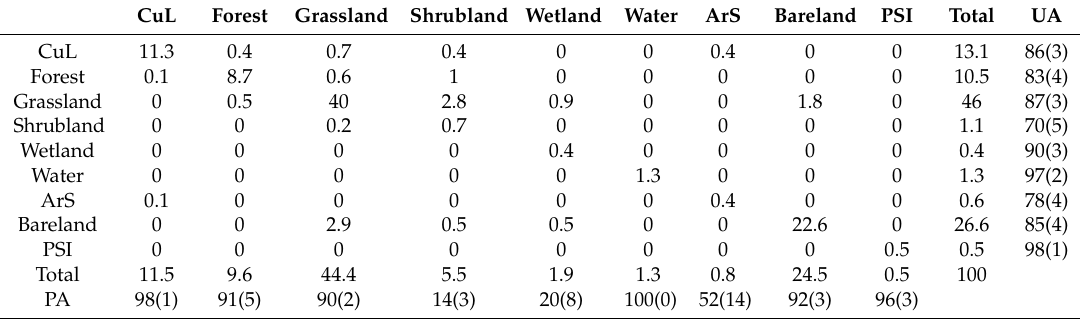
Table A4. The error matrix of estimated area proportions for R4: Overall accuracy is 76.0% (2.3%).